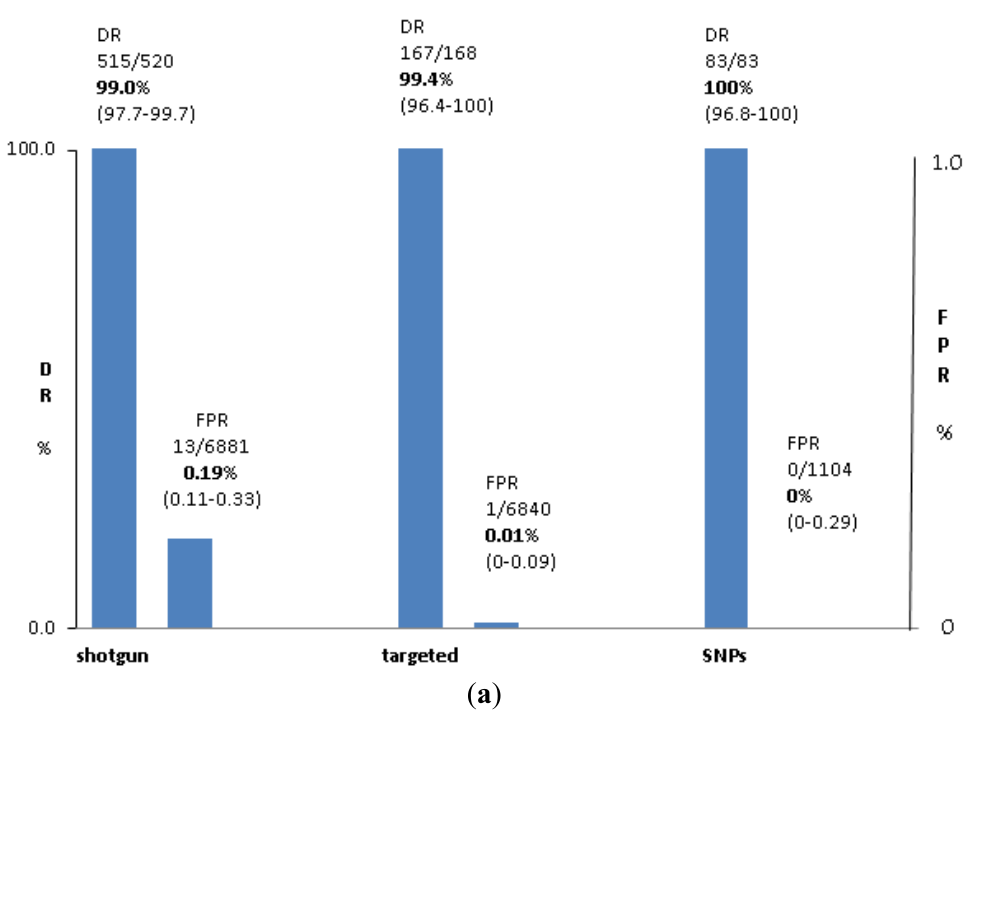
Figure 4. Summary detection rates and false-positive rates for ( a ) Down syndrome; ( b ) trisomy 18; ( c ) trisomy 13; and ( d ) all three trisomies combined for the three NIPT